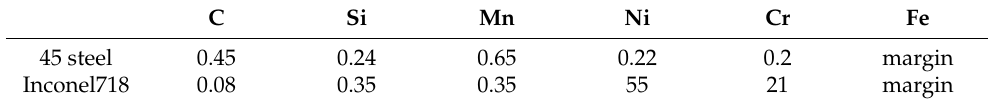
Table 3. Chemical composition of 45 steel and Fe45 powder (mass fraction, %).